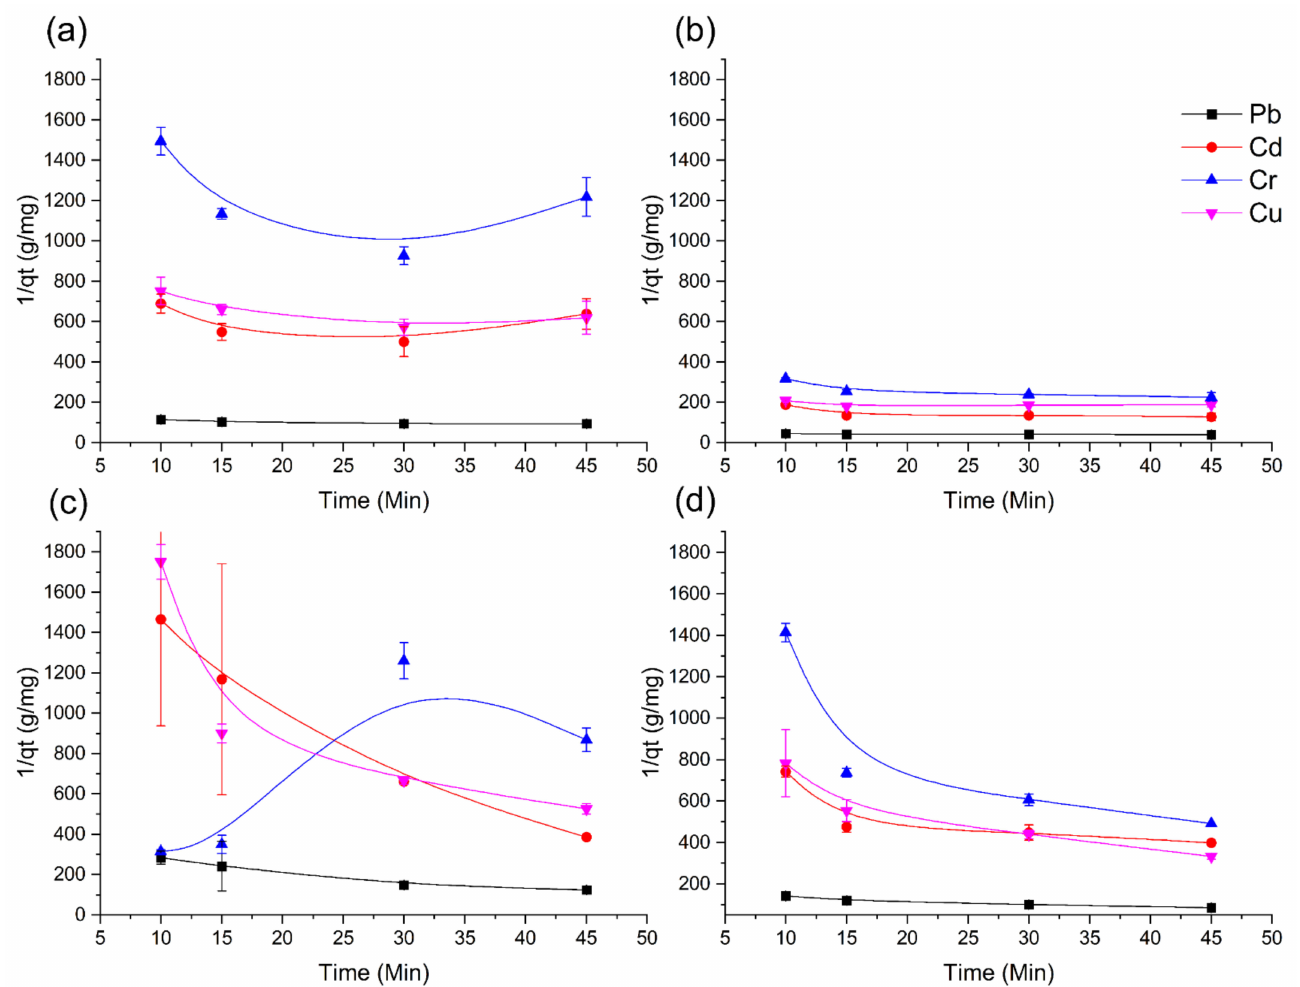
Figure 4. Pseudo-first-order model: ( a ) Coffee husk, ( b ) AgNPs–coffee husk, ( c ) lignin, and ( d ) AgNPs–